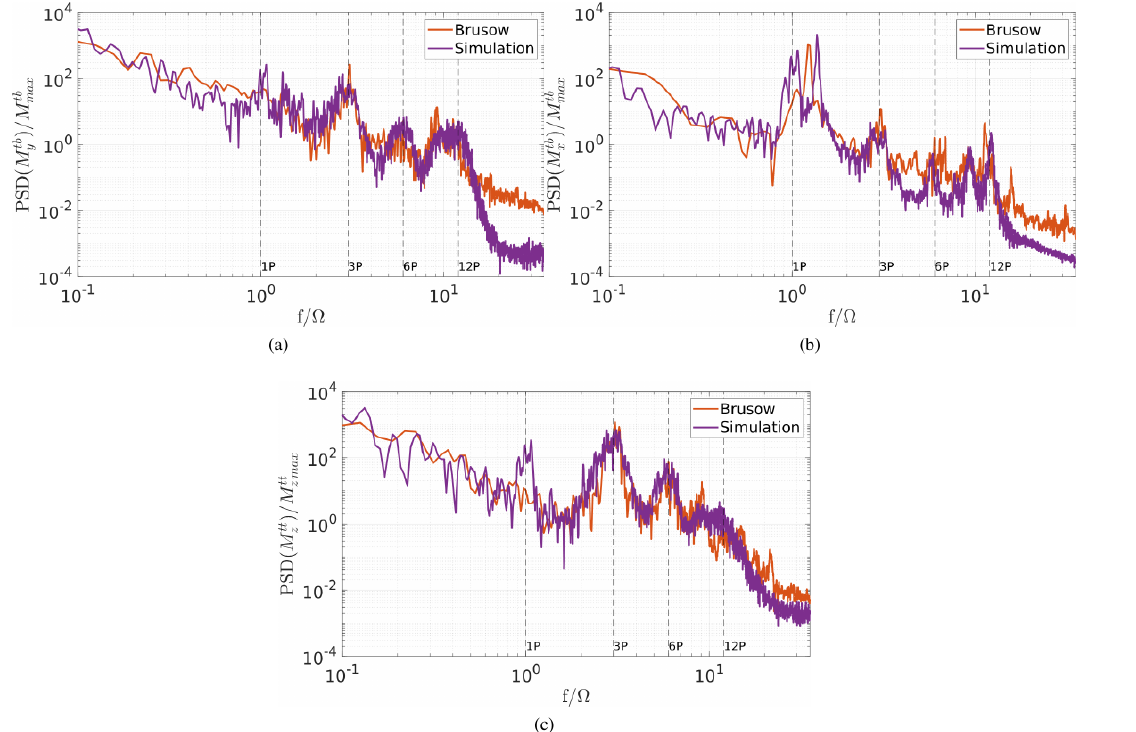
Figure B3. Spectrum of the tower moments: (a) the tower base bending moment in the fore-to-aft direction M tb y , (b) the tower base bending moment in the side-to-side direction M tb x and (c) the tower top torsion moment M tt z ; comparison of the measurement data to the simulation results (neutral). The data are normalised by the maximum value of the tower top torsion moment, and the frequency is normalised by the rotor speed.